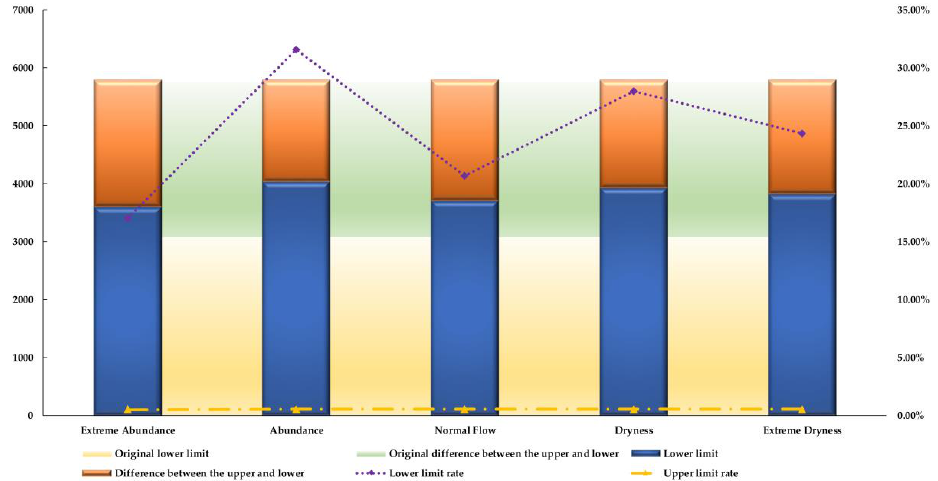
Figure 4. Optimization of economic benefits under the five hydrological scenarios in the Tingjiang River basin (×10 8 CNY). 4.3. Comparison of the IFTSC Model Optimized by Chance Constraint with the IFTS Model A modified optimization model for water resources optimal allocation in the Tingjiang River basin (IFTSC model) based on the opportunity constraint method in the stochastic programming using an interval-fuzzy two-stage chance-constraint stochastic optimization method was constructed from the optimization model (IFTS model) using an interval-fuzzy-two-stage stochastic optimization method. The two models were com- pared to analyse the significance and function of chance-constraint method optimization based on the degree of change in the total economic interests in the basin.